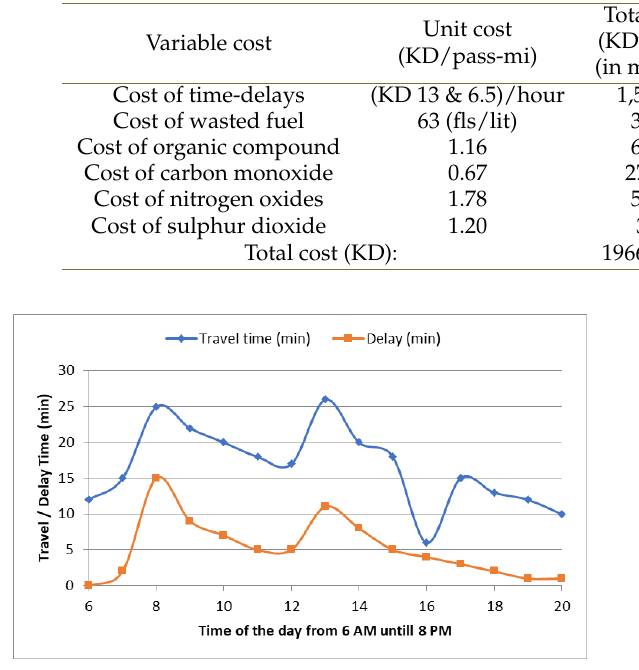
Fig. 2. Travel time and Delay of Cars in the 6 th ring road.